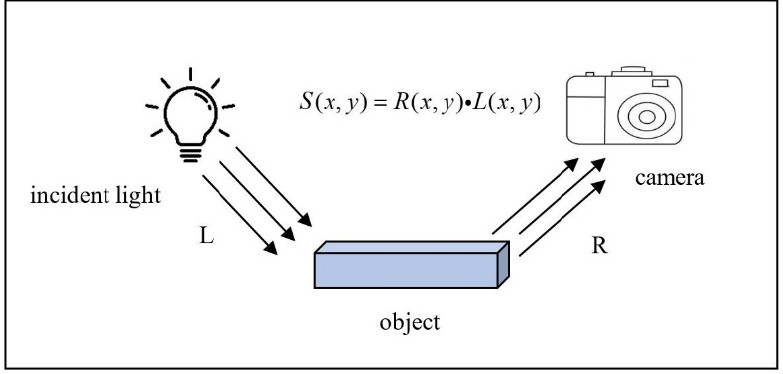
Figure 2. Schematic diagram of the Retinex algorithm.